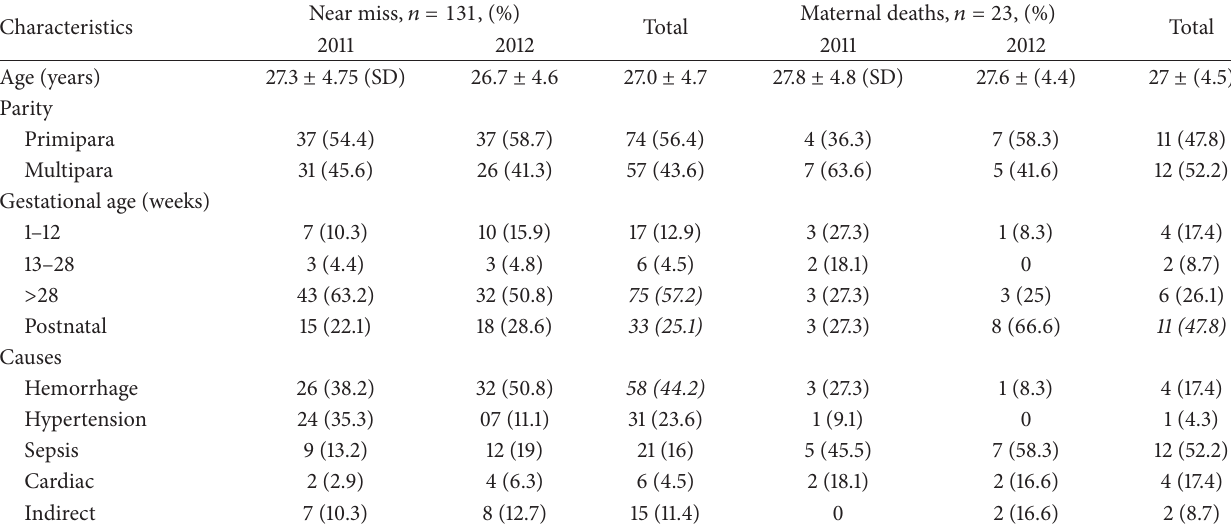
Table 1: Characteristics of near miss cases and maternal